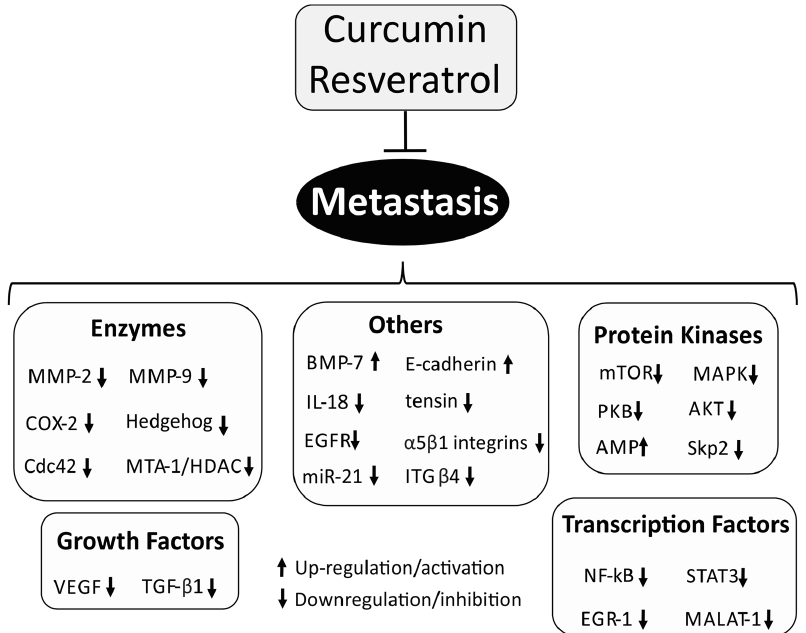
Figure 2. The control of metastasis by curcumin and resveratrol.